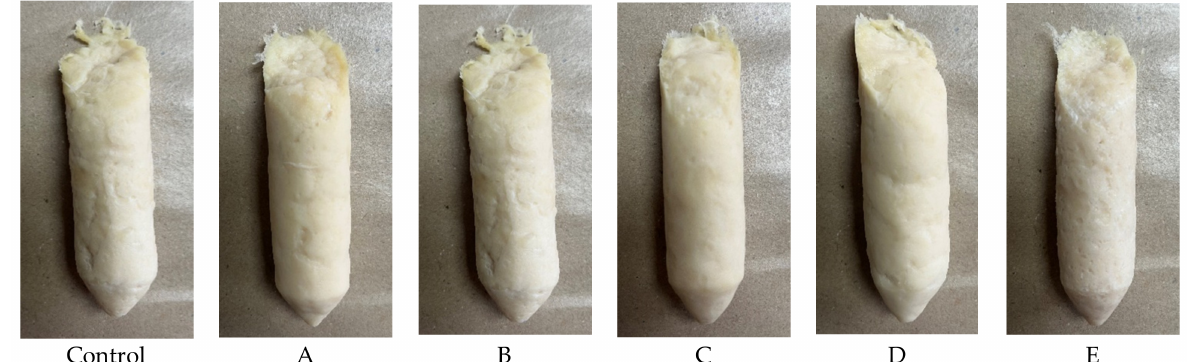
Figure 1. The images of cooked fat-replaced samples with palm shortenings (PS) of various melting ranges (MR) as compared to the control sample with chicken skin. Control (chicken skin), sample A (PS at MR of 33–36 ◦ C), sample B (PS at MR of 38–42 ◦ C), sample C (PS at MR of 44–46 ◦ C), sample D (PS at MR of 45–49 ◦ C), and sample E (PS at MR of 55–60 ◦ C).